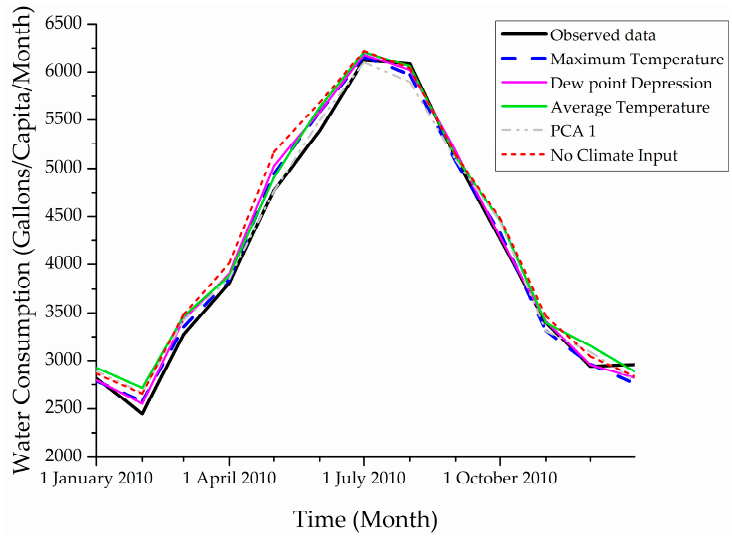
Figure 7. Time-series of observed monthly water consumption and predicted data calculated from the ARIMA (no climate input) model, and the ARIMAX with maximum temperature, average temperature, dew point temperature, and PCA1 models in 2010.